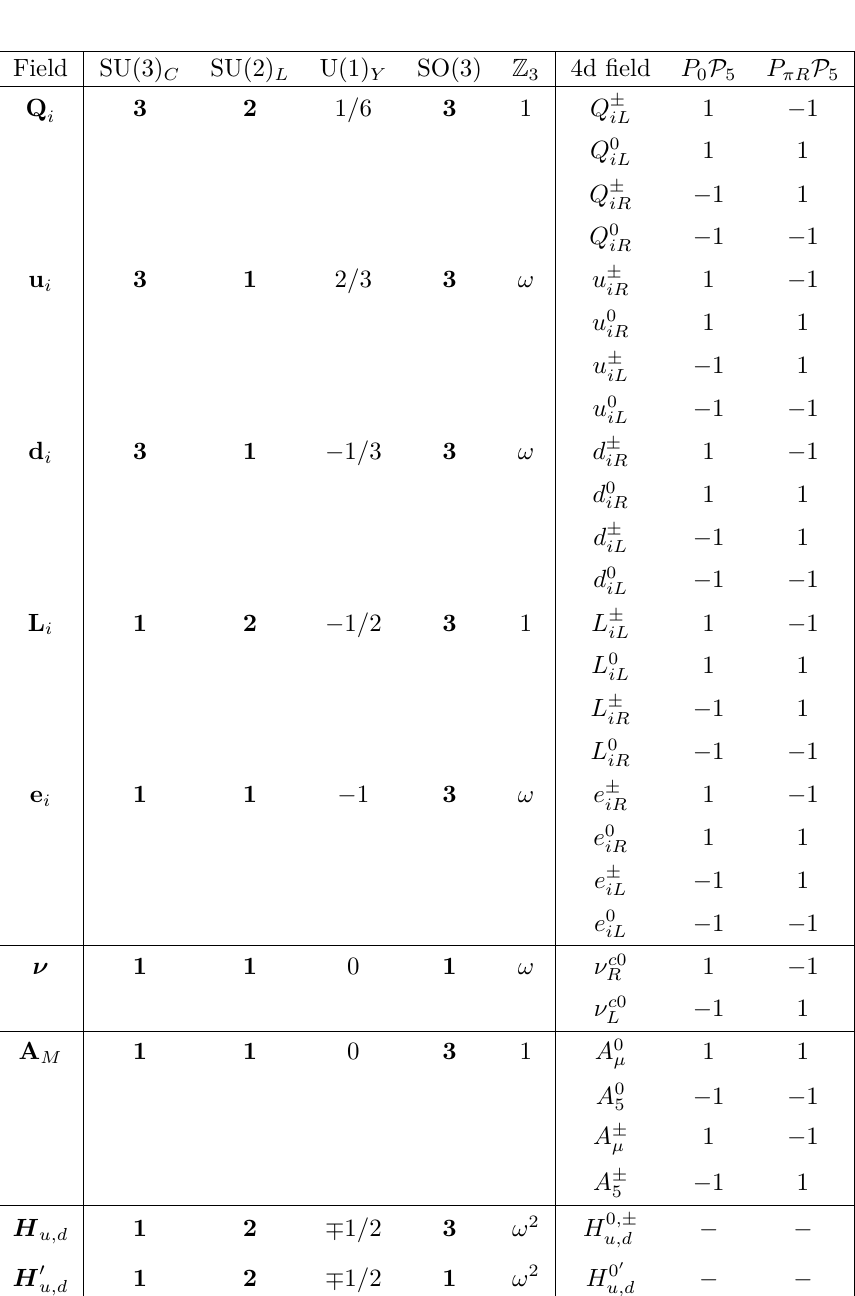
Table 1 . The field content of the model, comprising three 5d SM fermion families Q , u i , d i , L i , i e i , plus one singlet neutrino ν , plus the 5d SO(3) gauge field A M , with their decomposition under the orbifold breaking. The index i = 1 , 2 , 3 is a family index not an SO(3) index, i.e. there are three families of SO(3) isotriplets. When the SO(3) is broken to a U(1) 0 by the orbifold, this will yield a massless neutral fermion (under the U(1) 0 ) for each fermion family. There is also an U(1) 0 charged scalar φ in the πR/ 2 brane, whose VEV will eventually break the U(1) 0 , yielding a massive Z 0 . As it is an incomplete SO(3) multiplet, it is not shown in this table. The 5d SM gauge fields are not displayed explicitly here. The 4d scalar Higgs doublets on the branes are also shown, with H u,d on the zero brane and H 0 on the other brane. u,d